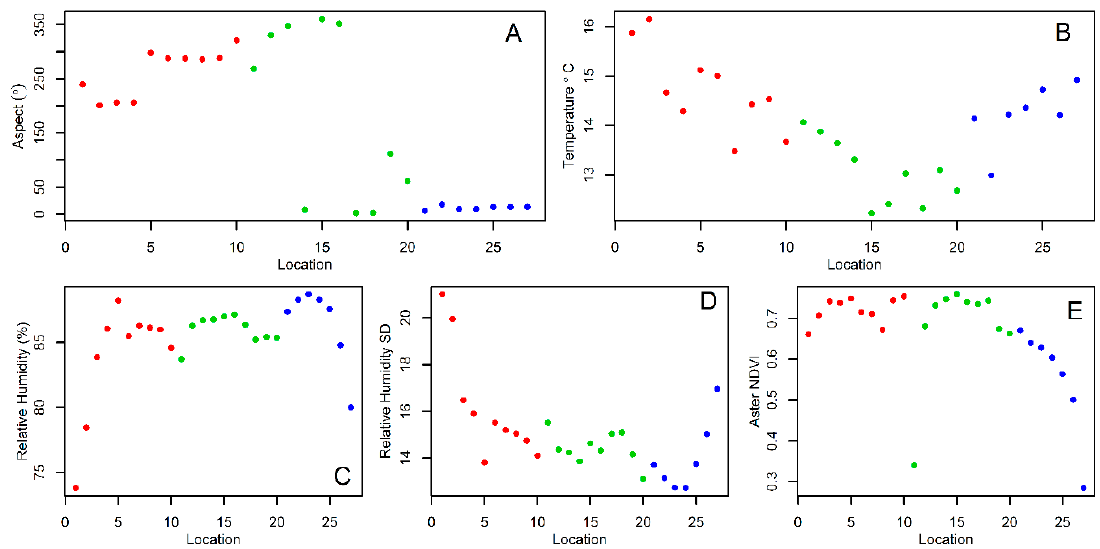
Figure 5. Environmental covariates associated with Tripteroides bambusa spatial persistence at the sampling locations: ( A ) aspect, ( B ) mean relative humidity, ( C ) SD relative humidity, ( D ) mean ovitrap water temperature, and ( E ) mean Advanced Spaceborne Thermal Emission and Reflection Radiometer (ASTER) normalized difference vegetation index (NDVI). In all plots, numbers and colors represent, respectively, the sampling locations and transects described in Figure 2.